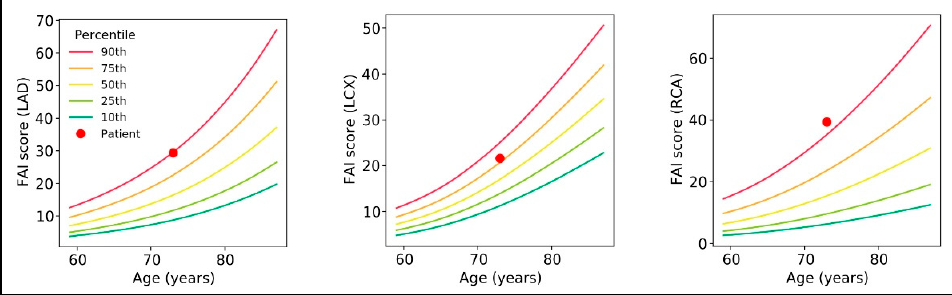
Figure 2. Nomograms with percentile curves for FAI-Score, adjusted for age, gender, and risk factors for each major coronary territory.